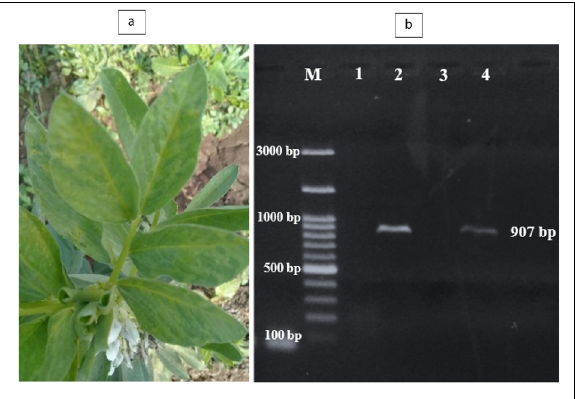
(a) Bean yellow mosaic virus (BYMV) phenotypic symptoms. (b) Gel electrophoresis image of the RT-PCR test conducted to identify BYMV: Lanes 1 & 3: healthy plant controls; Lanes 2 & 4: BYMV-infected faba bean plants; Lane M: 100-bp DNA